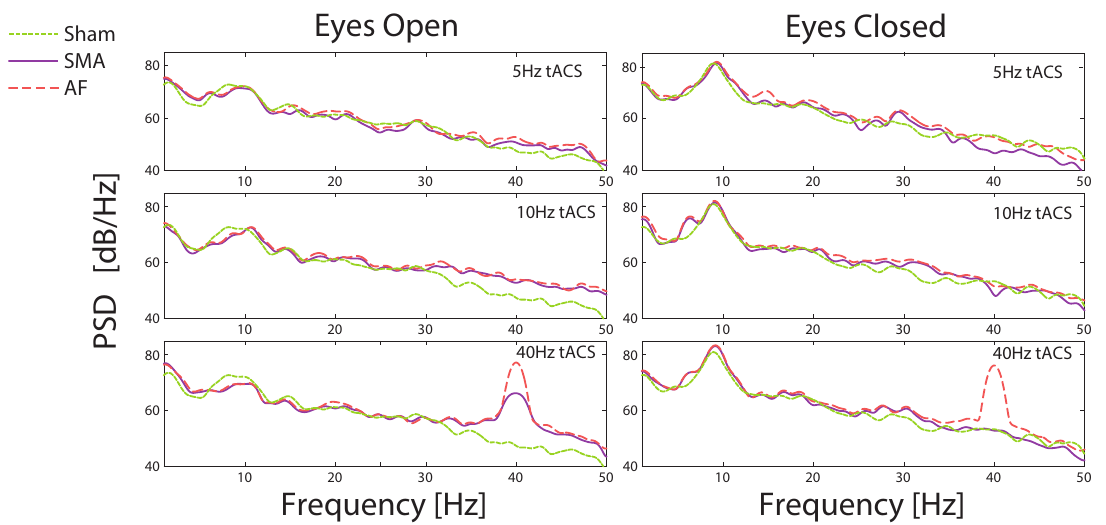
Figure 9. Power Spectral Density (PSD) data, at PO8, during the alpha task protocol for a single subject with stimulation at 5 Hz (top), 10 Hz (middle) and 40 Hz (bottom), 250 µ A amplitude. The protocol is split into 2 sections, Eyes Open (left) and Eyes Closed (right). An increase in alpha activity (8–12) Hz is seen when the eyes are closed in all cases.